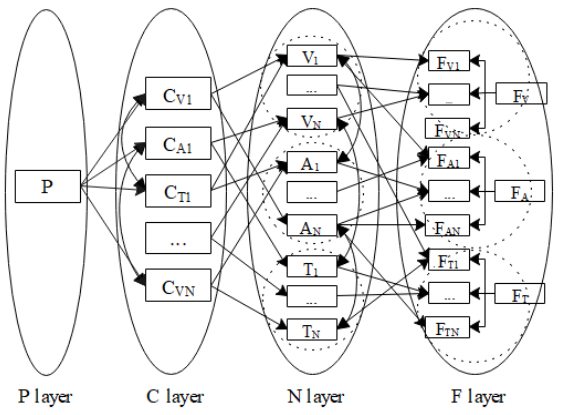
Figure 4. Mapping between domains.